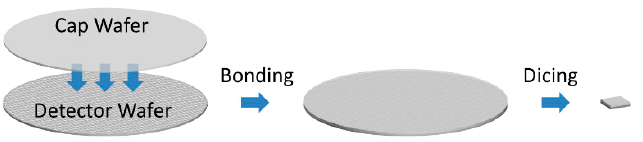
Figure 9. Concept of the wafer level packaging technology.